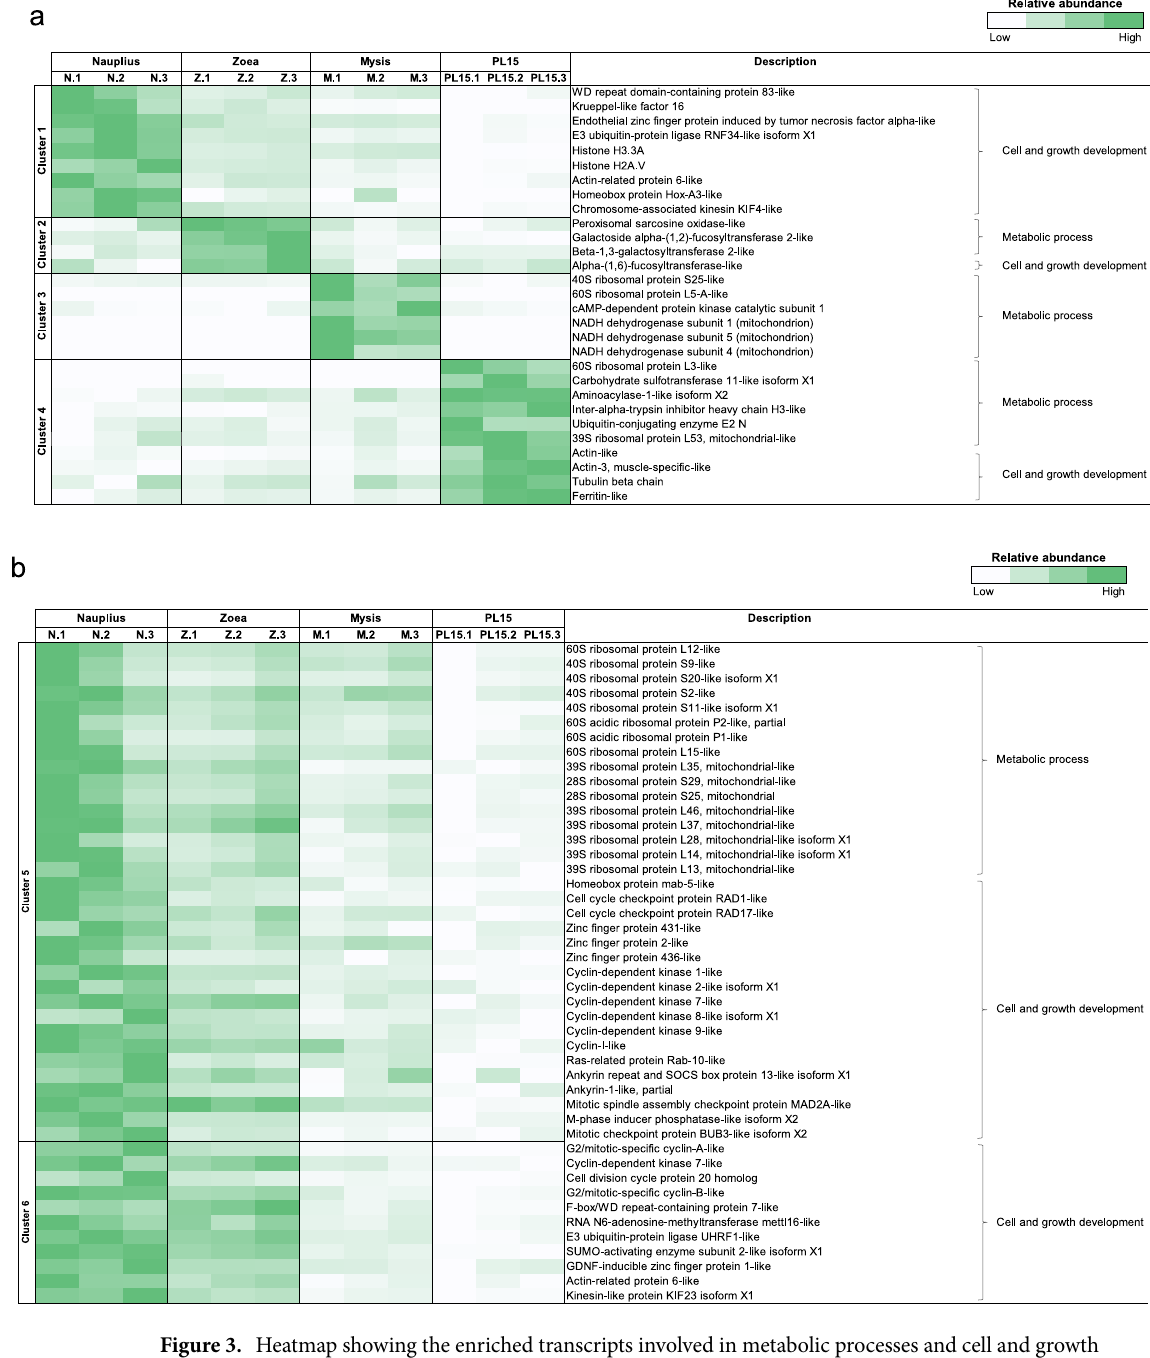
Figure 3. Heatmap showing the enriched transcripts involved in metabolic processes and cell and growth development associated with early shrimp stages, which were divided to nauplius (N), zoea (Z), mysis (M) and 15-day-old postlarva (PL15). ( a ) Cluster 1–4 shows the pattern of highly gene expressed profiles in nauplius, zoea, mysis and 15-day-old postlarva. ( b ) Cluster 5–6 shows decreasing pattern of gene expression from nauplius to postlarval stage, ( c ) cluster 7–8 shows increasing pattern of gene expression from nauplius to postlarval stage, and ( d ) cluster 9 shows the pattern of unchanged in gene expression across all life